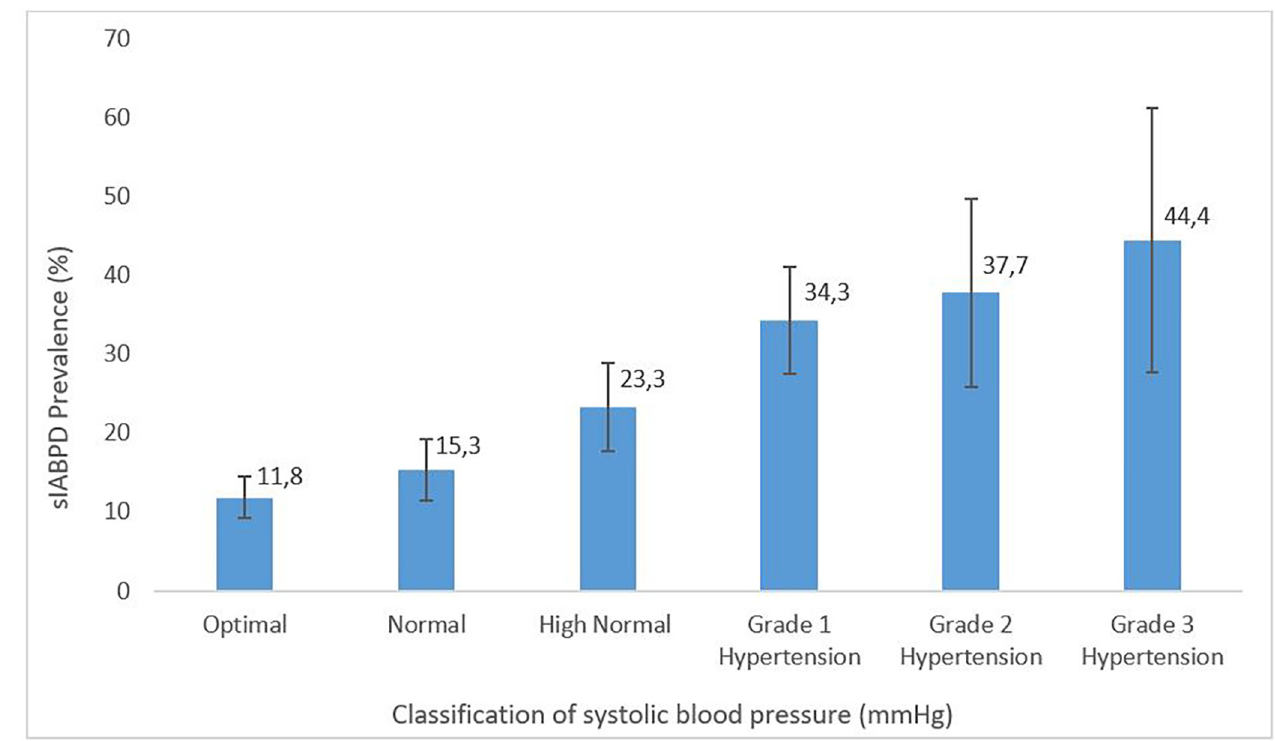
Fig 4. Prevalence of sIABPD � 10 mmHg by systolic blood pressure classification, TAHES study, Benin 2020.